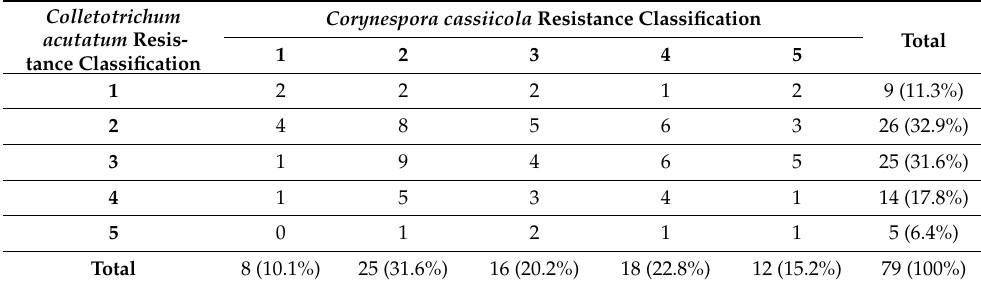
Table 1. Numbers (and percentages) of H. brasiliensis x H. benthamiana F 1 progeny classified between 1 (highly resistant) and 5 (highly susceptible) for resistance against Colletotrichum acutatum and